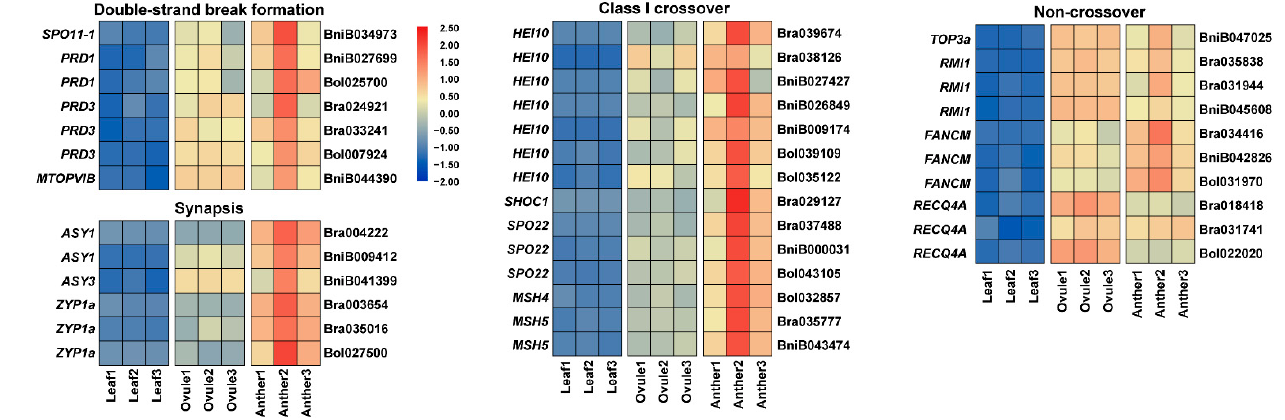
Figure 3. The expression patterns of double-strand break formation, synapsis, class I crossover and non-crossover–related genes in Anther, Ovule and Leaf of Brassica allohexaploids.